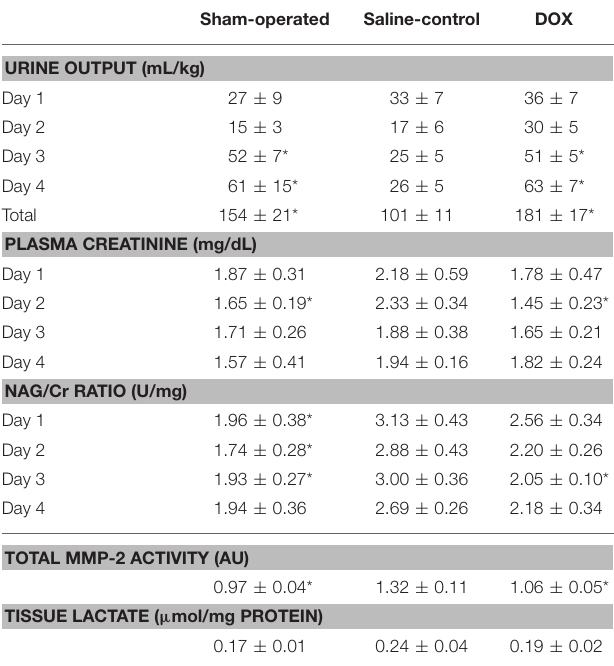
TABLE 4 | Changes in various renal biomarkers during